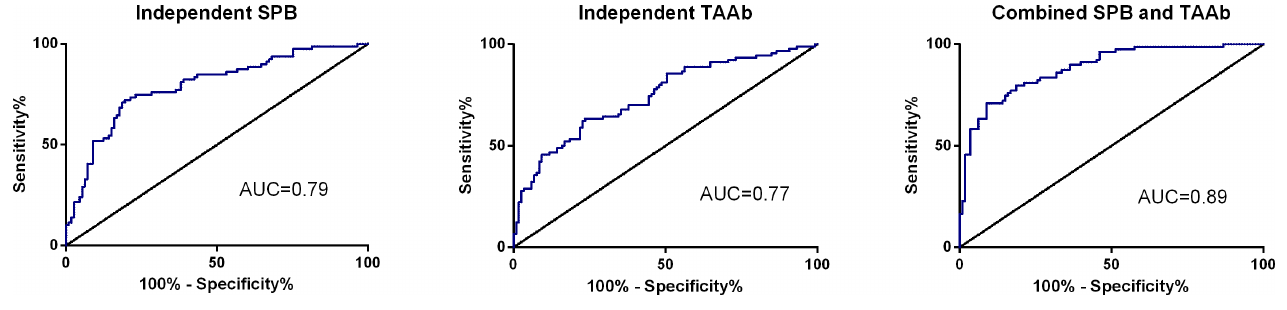
Fig 2. ROC curves for Models. Area under the curve (AUC) shown for each model in the